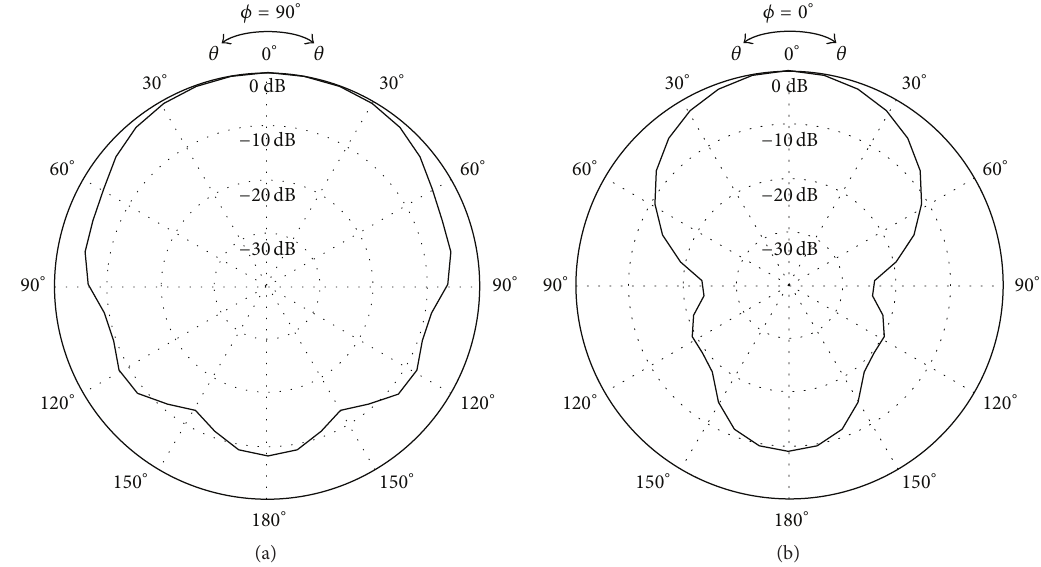
Figure 6: The simulated radiation patterns of the antenna without parasitic coupling apertures at 2.45 GHz: (a) 𝐸 -plane and (b) 𝐻 -plane.